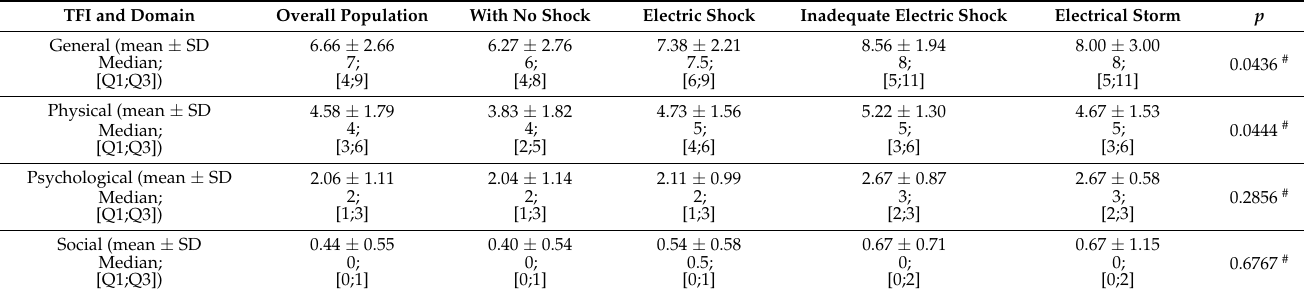
Table 2. Number of points obtained in the total TFI score as well as in its domains according to the electric shocks. TFI and